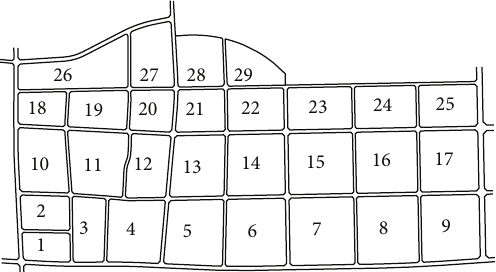
Figure 2: Flow chart of IPSO.